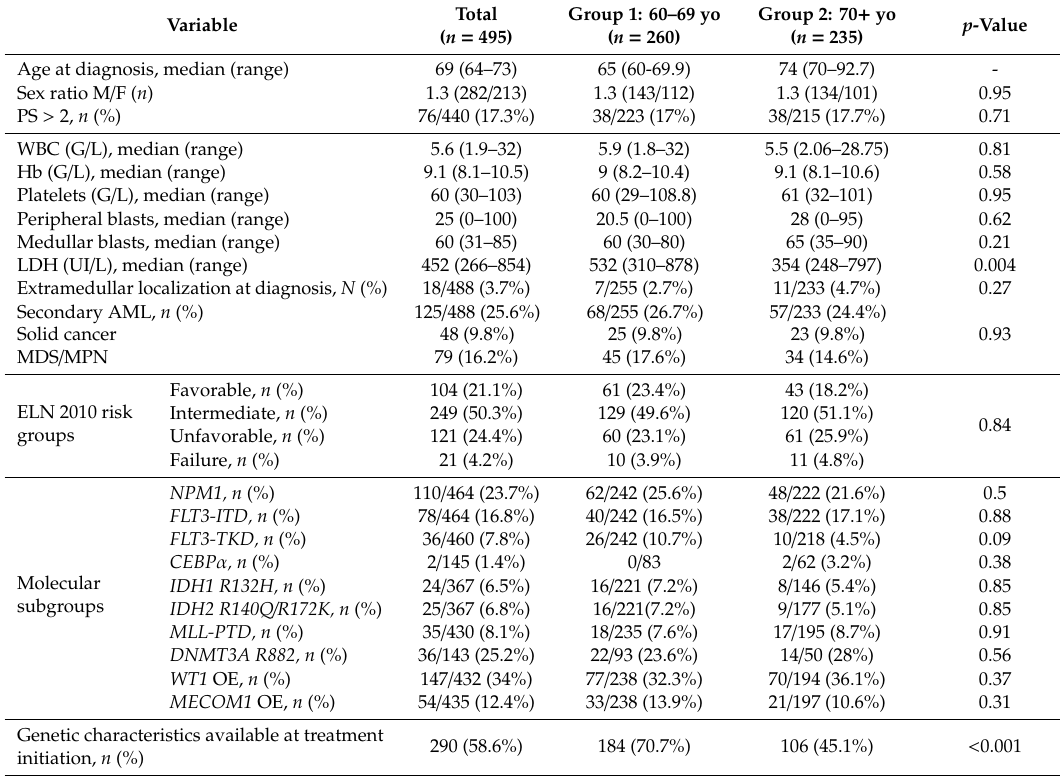
Table 1. Demographic, biological and clinical characteristics at baseline stratified by age group: group 1 (age 60–69 years old) and group 2 (age ≥ 70 years